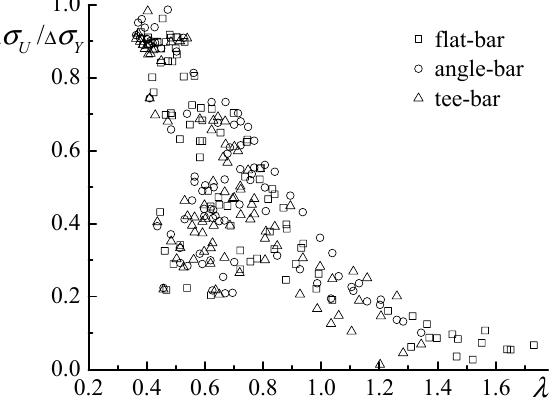
Figure 12. The increase ratio of ultimate strength of the sti ff ened plates plotted against column slenderness ratio.